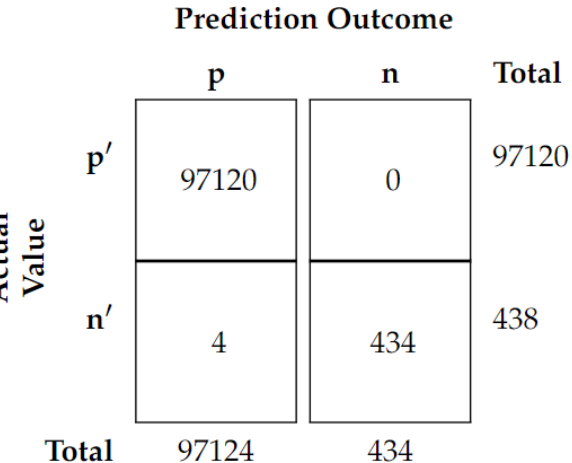
Figure 8. Confusion matrix showing the results of a classification model and comparing the actual values to the predicted outcomes. The table displays the number of True Positives, True Negatives, False Positives and False